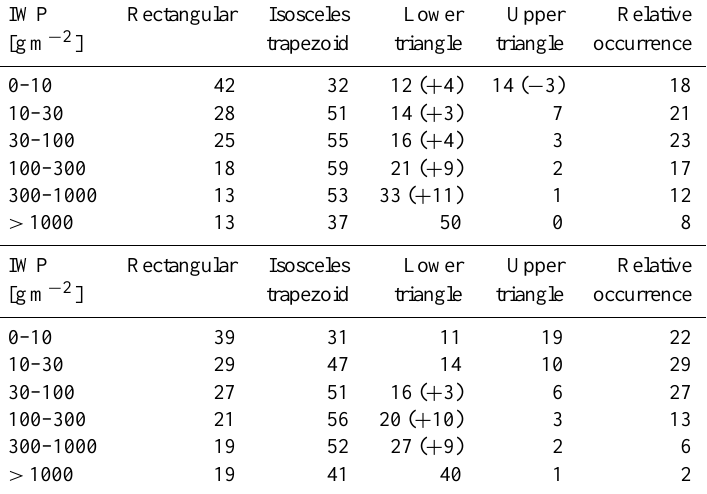
Table 5. (a) Normalized occurrence of basic IWC profile shapes for different IWP intervals, for single layer high ice clouds. The rightmost column shows the relative occurrence per IWP interval. All values are in percent. Values in brackets refer to anomalies associated with strong downdraft ( > 175hPaday − 1 ) within the cloud (at AIRS z cld ) . If no value in brackets is given, the change is smaller than 2%. (b) Same as (a) , but for multi-layer cloud scenes, for which the uppermost layer contains high ice cloud. Rectangular Isosceles